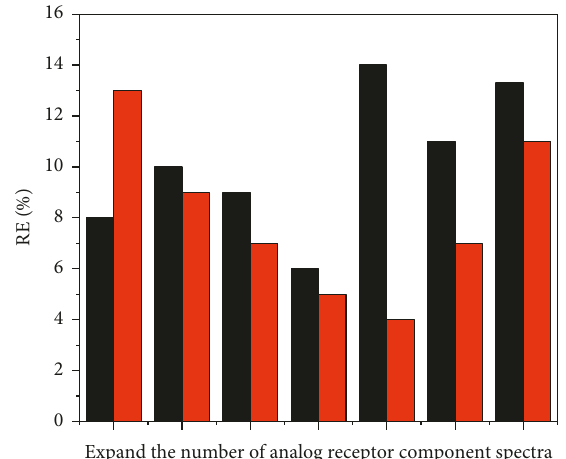
Figure 5: RE diagram of the contribution rate of each source of extended data relative to the PCA analytical contribution rate of measured data under different extended simulated receptor component